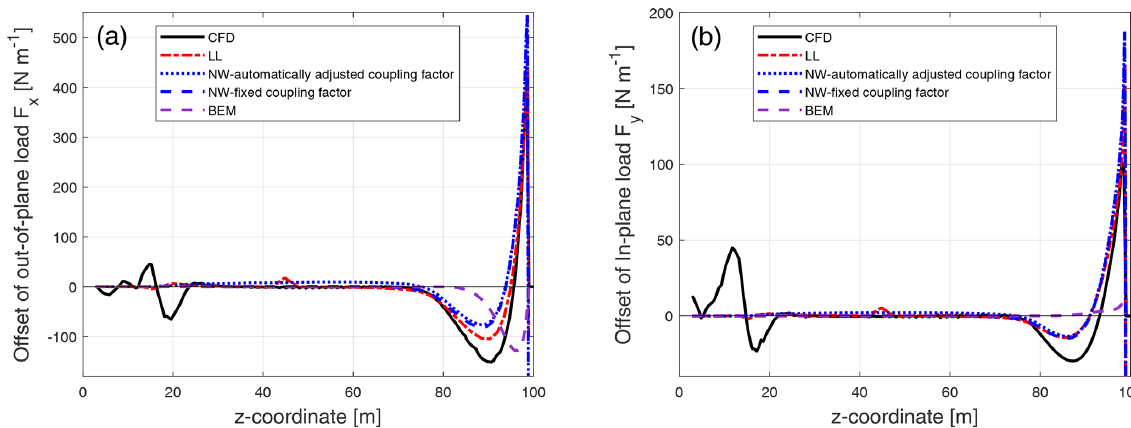
Figure C3. Comparison of the difference between the out-of-plane load (a) and the in-plane load (b) of the backward swept Blade-4 with respect to the baseline blade calculated from the Navier–Stokes solver (CFD), the lifting-line method (LL), the proposed coupled method (NW) and the blade element momentum method